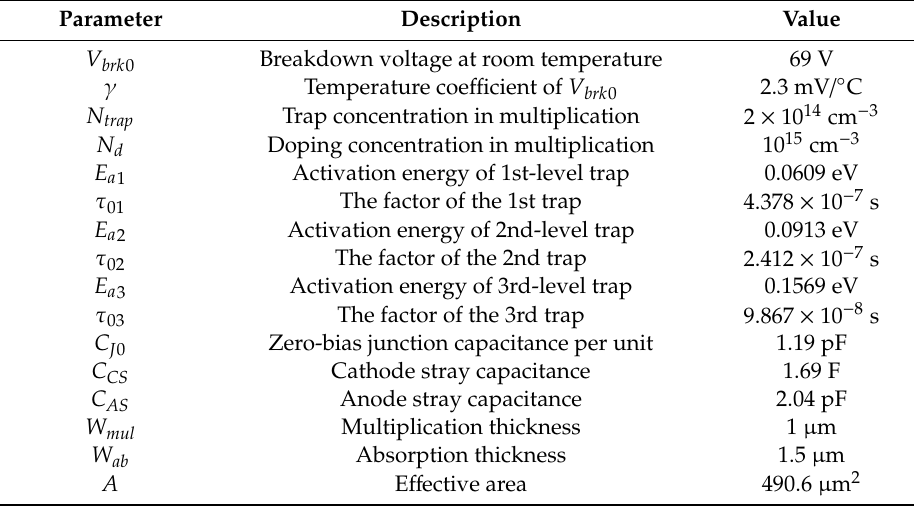
Table 1. Summary of key parameters.